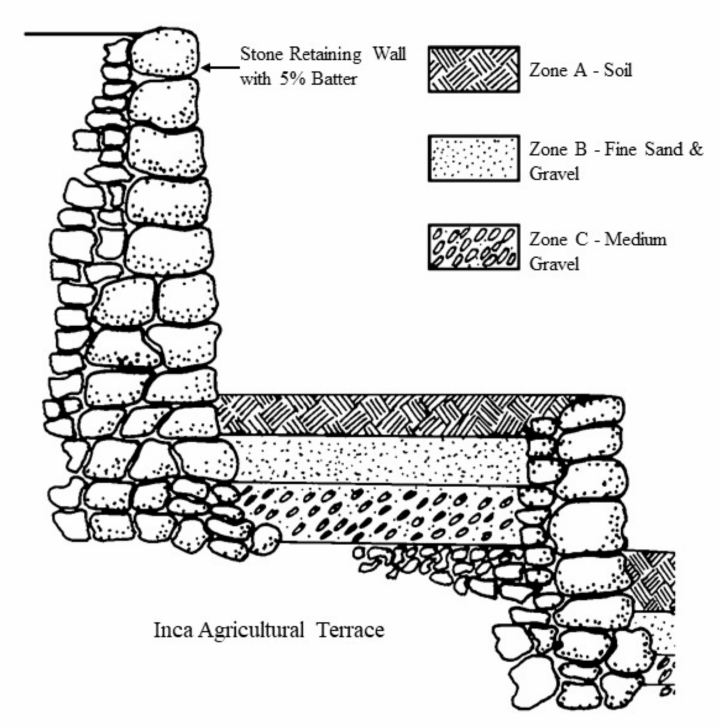
Figure 10. Good subsurface drainage in the agricultural terraces ensured that much of the rainfall percolated down into the permeable zone. (Reproduced from Machu Picchu: A Civil Engineering Marvel [5], with permission from ASCE, the publisher.)